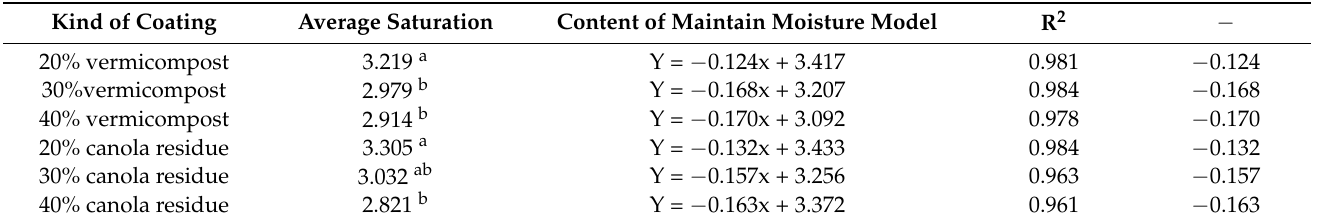
Table 3. Linear model of weight in saturation condition and moisture content in kinds of organic